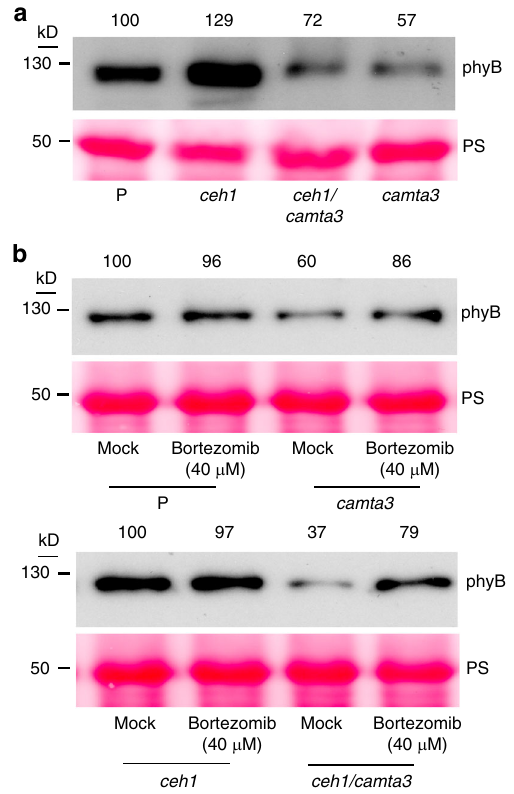
Fig. 8 CAMTA3 stabilizes phyB protein abundance. a phyB protein abundance in nontreated 7-day-old LD grown P, ceh1 , ceh1 / camta3 , and camta3 seedlings. b phyB protein abundance in 7-day-old LD (16 h light/8 h dark) grown P, ceh1 , ceh1 / camta3 , and camta3 seedlings in the absence (mock, 0.1% DMSO) and presence of the 26S proteasome inhibitor, bortezomib. Ponceau S (PS) staining was used as loading control. Numbers on top of the immunoblot images represent normalized phyB abundance in various genotypes and in response to bortezomib treatment relative to the P (the top two panels) or ceh1 (the bottom panel)